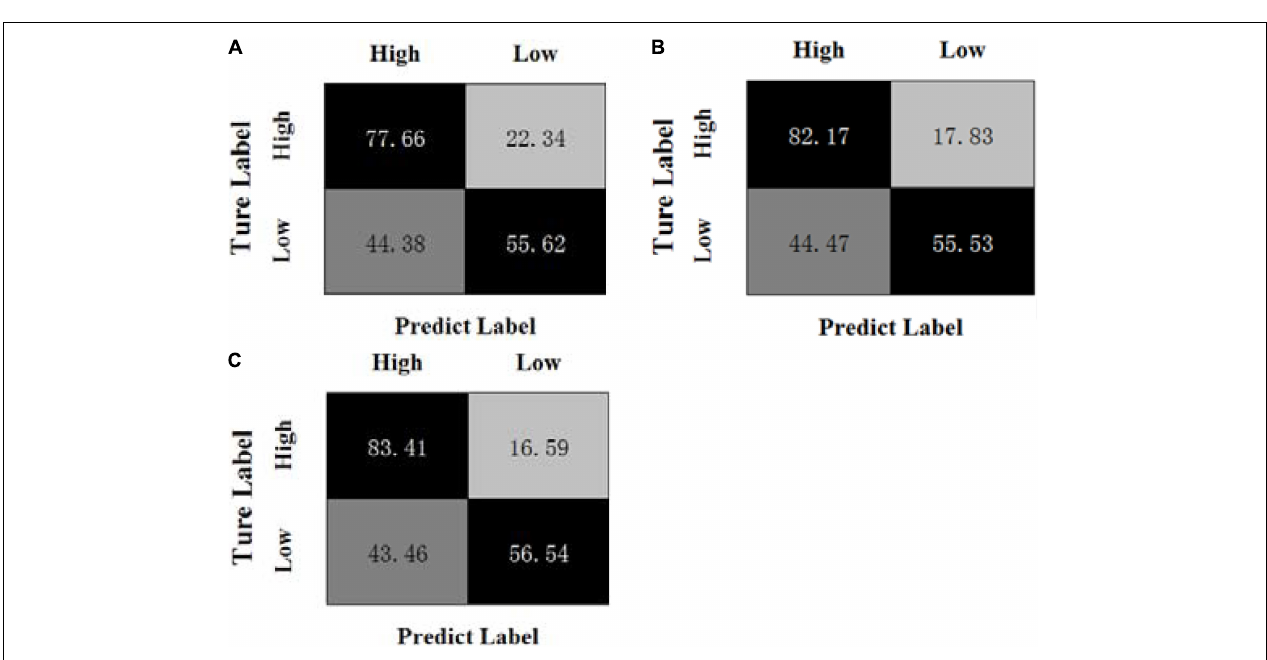
FIGURE 3 | Confusion matrices of OPFDDL on the DEAP dataset in valence, (A) β + γ , (B) α + β + γ , (C) θ + α + β + γ .